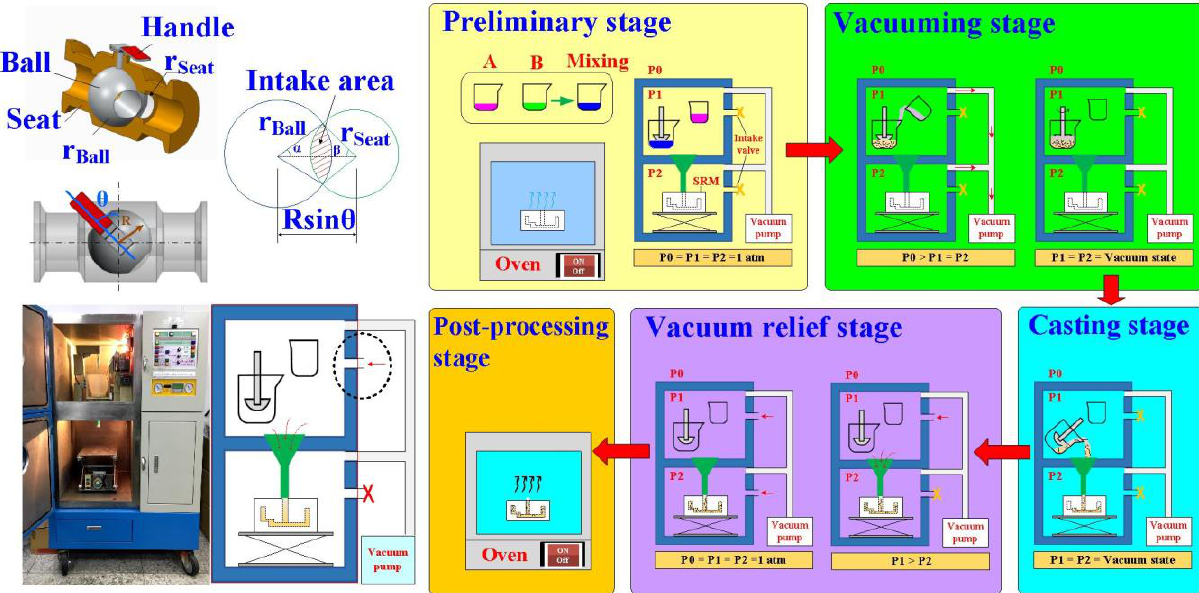
Figure 7. Five stages of the VC and information about ball value and intake area.